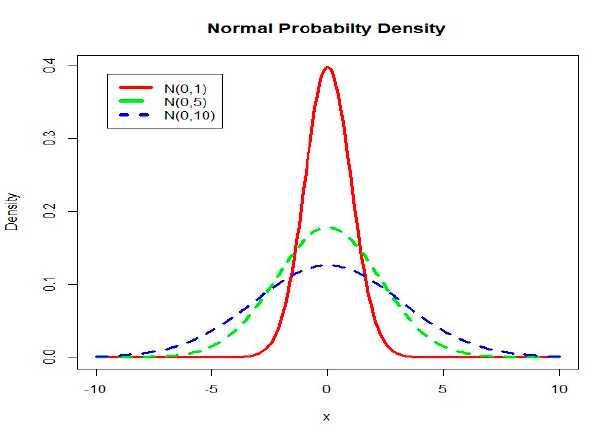
μ = 0 and variance 2